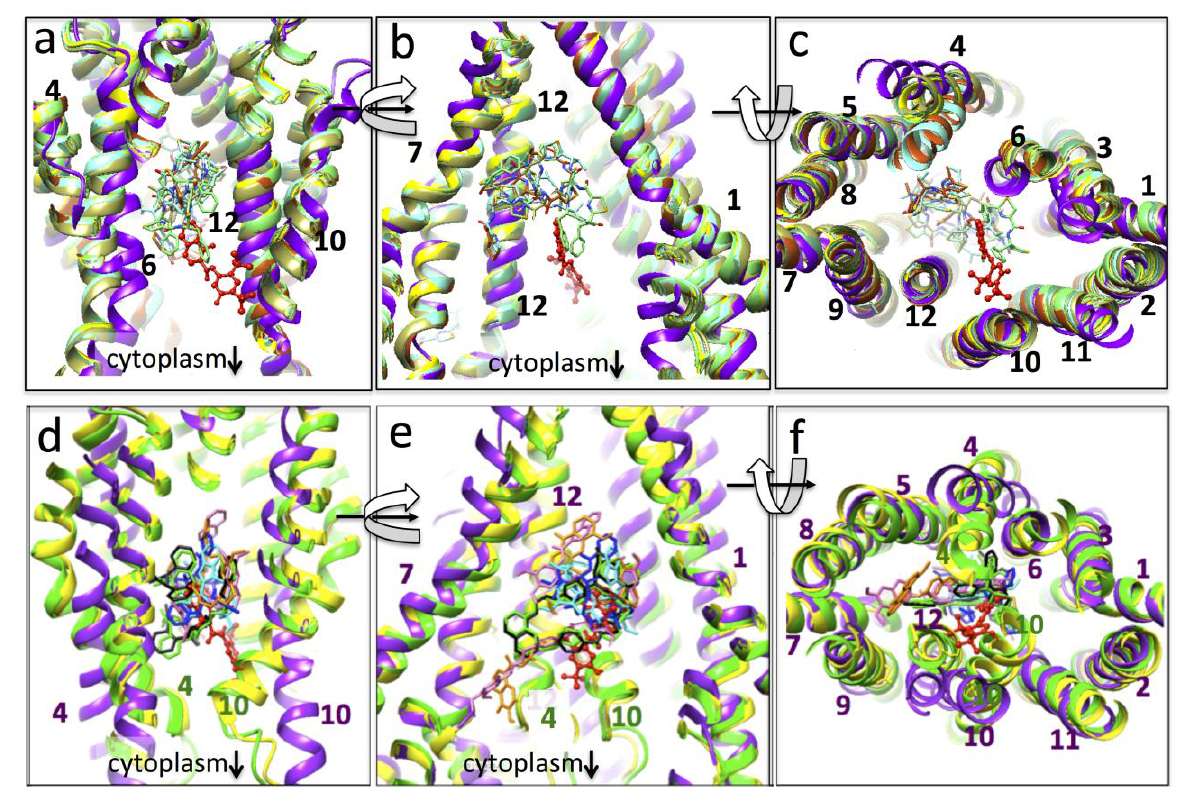
Figure 4. Location of drugs and inhibitors within the P-gp central binding cavity: ( a – c ): Murine P-gp models. Purple ribbon is the atomic model for map a in this paper (ivacaftor- red): yellow, PDBID 4q9h- apo-state; cyan, 4q9j- with QZ-Val; orange, 4q9i-QZ-Ala; taupe, 4q9k-QZ-Leu; green, 4q9l-QZ-Phe; turquoise, 4xwk-BDE-100. The modeled position of ivacaftor sits further towards the cytoplasm than the various inhibitors shown. Trans-membrane helices are numbered according to their position in the P-gp sequence. ( a , b ) are orthogonal views along the membrane plane; ( c ) is the view from the cytoplasm. Curved arrows indicate the 90° rotations involved. ( d – f ): Human and human/mouse chimera P-gp: no drug (6fn4, yellow ribbon); with zosuquidar (6fn1, green ribbon, green drugs, and black drugs-7a6f); tariquidar (7a6e, pink drugs); vincristine (7a69, cyan drug); taxol (6qex, blue drug); elacridar (7a6c, orange drugs). Wider separation of the murine NBDs necessitated alignment of the N- and C-terminal arms of the model (this paper, purple ribbon, red drug) with the human P-gp structures. Where major differences exist between the paths of transmembrane helices in human and murine models, they are numbered in both purple and green font.